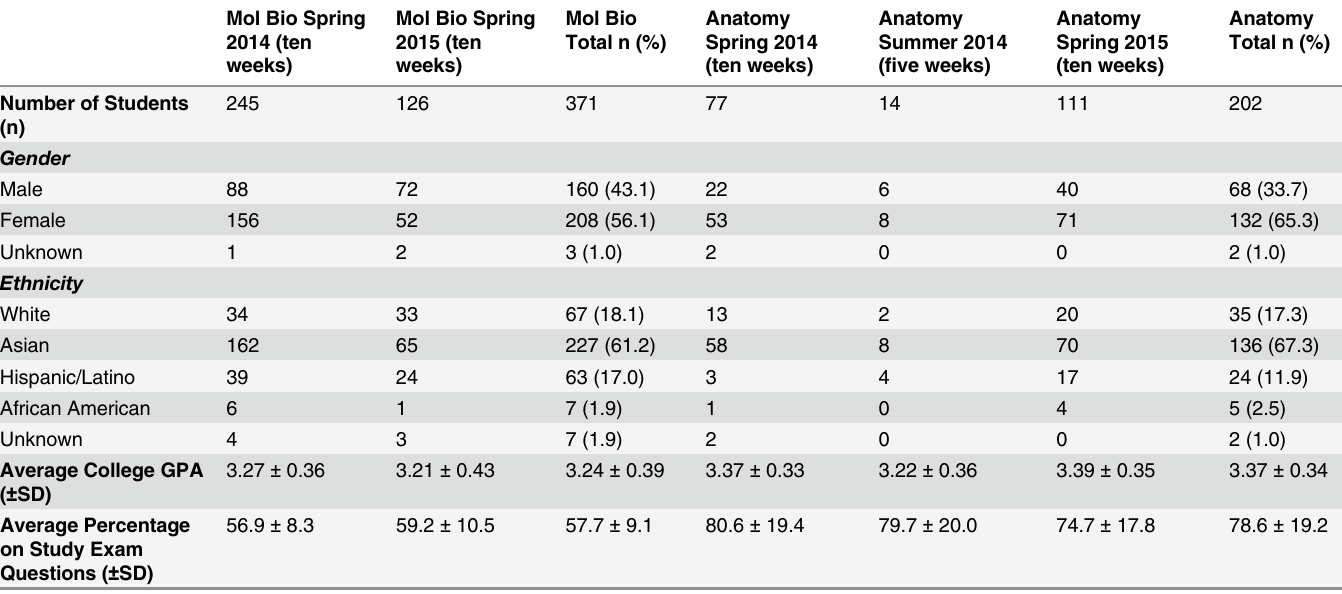
Table 1. Descriptive statistics of the students in the study